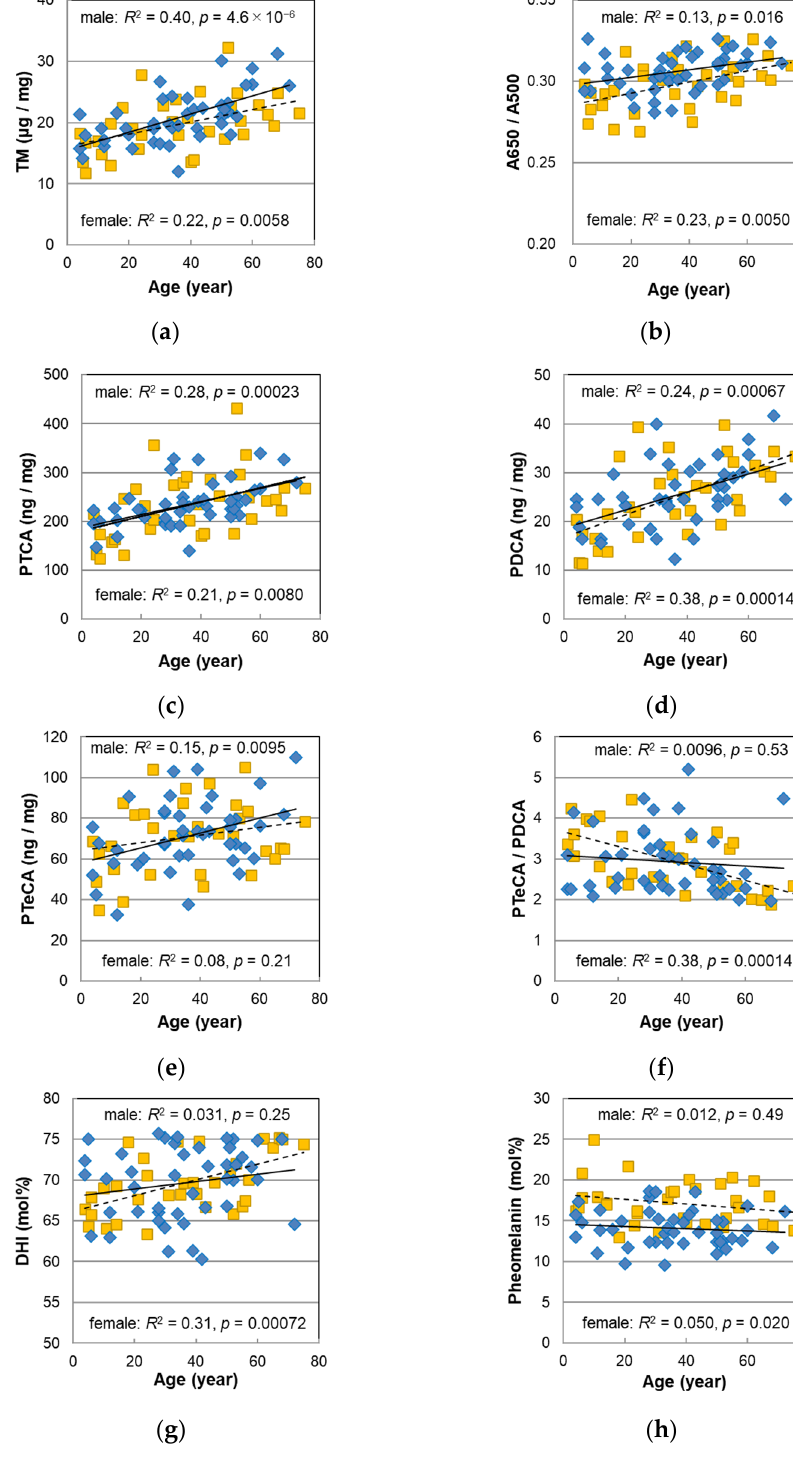
Figure 2. The age dependencies of various values measured with melanin analyses of Japanese male (diamonds) and female (squares) pigmented hairs. ( a ) Total melanin amount (TM). ( b ) Absorbance ratio of 650 nm to 500 nm (A650/A500) of the Soluene-350 solution of hair melanin. ( c ) Level of pyrrole-2,3,5-tricarboxylic acid (PTCA) in hair. ( d ) Level of pyrrole-2,3-dicarboxylic acid (PDCA) in hair. ( e ) Level of pyrrole-2,3,4,5-tetracarboxylic acid (PTeCA) in hair. ( f ) The ratio PTeCA/PDCA.